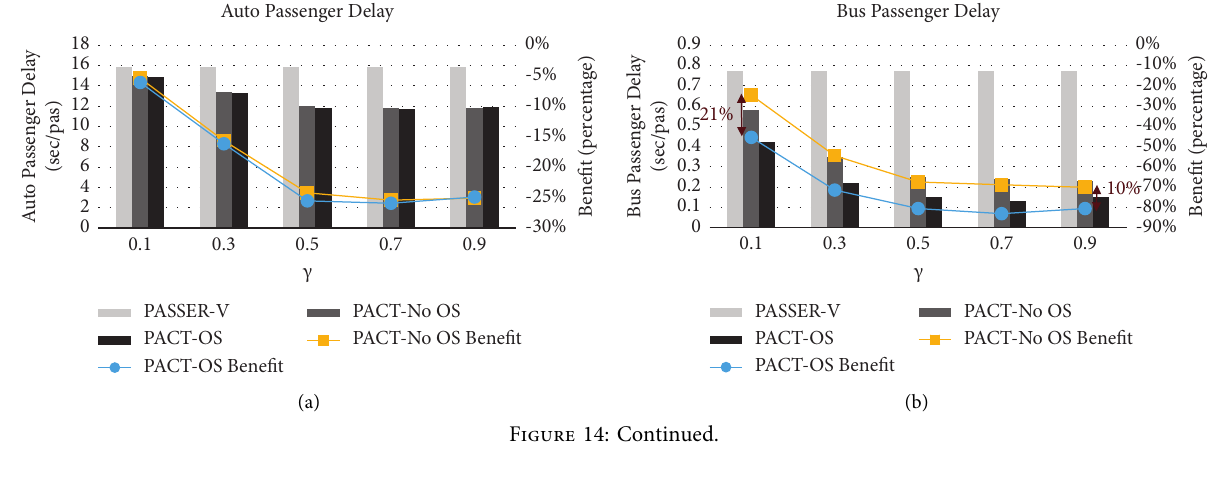
PACT-No OS PACT-No OS Figure 14: